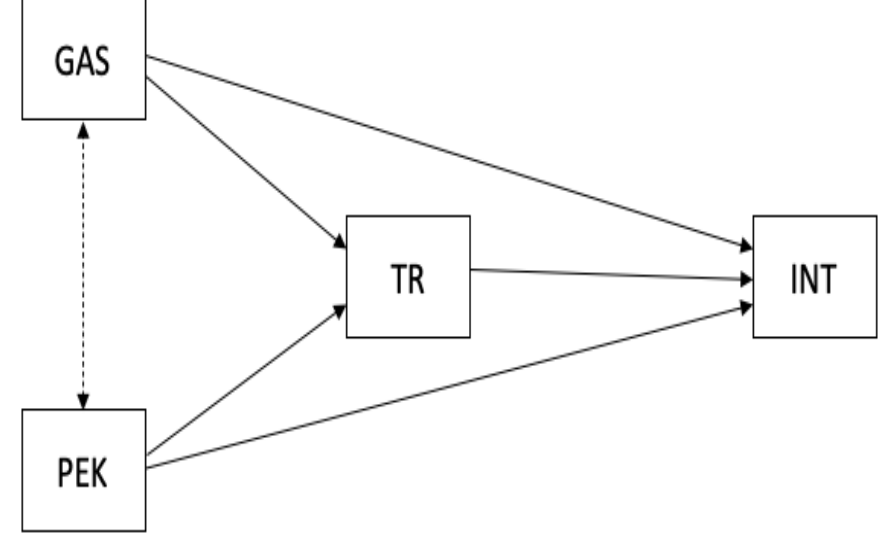
Figure 1. Conceptual framework of the study. GAS = green advertising skepticism; PEK = perceived environmental knowledge; TR = trust in green claims; INT = intention to by green